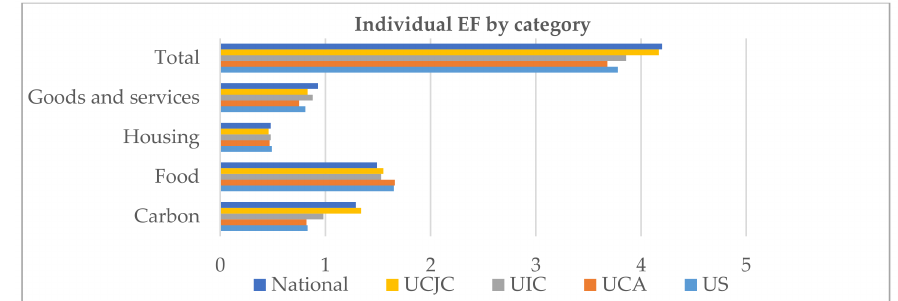
Figure 1. Results (in gh) for individual environmental footprint (EF) disaggregated by category and compared to the national average (the data of the Ecological Footprint of each student is provided as supplementary material in Table